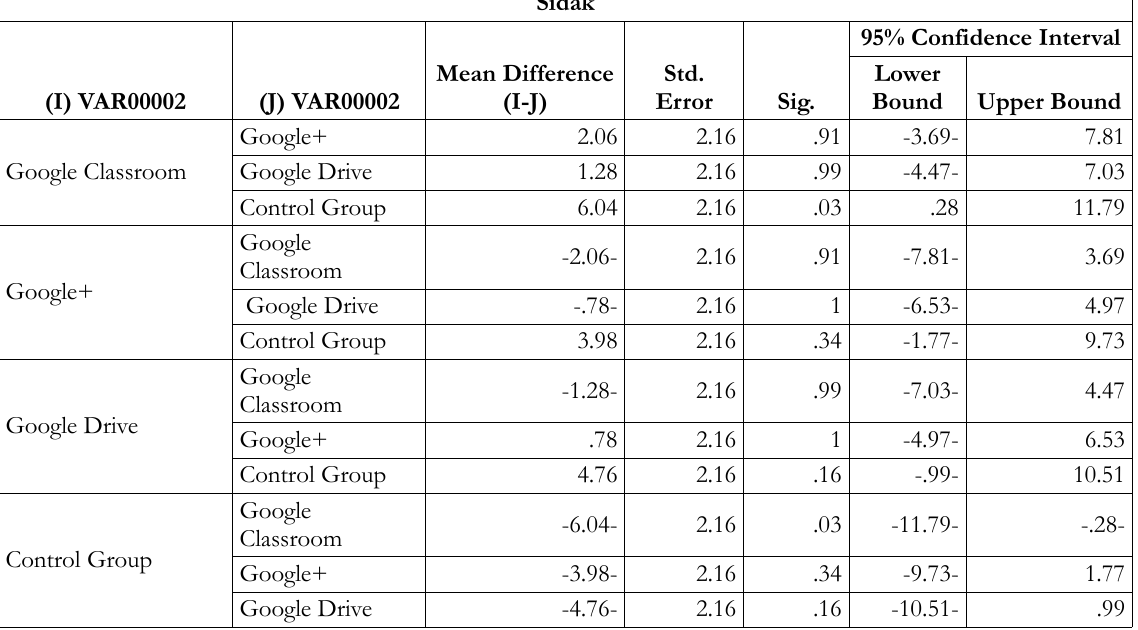
Table 6. Multiple Comparisons